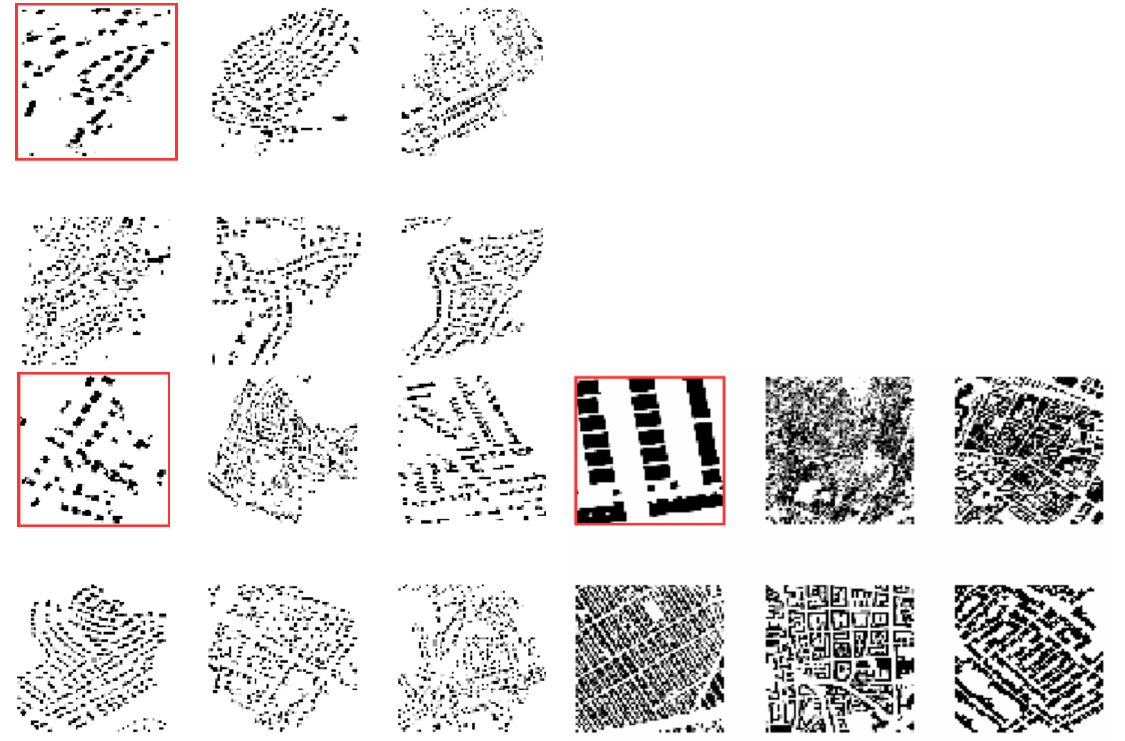
Figure 11. Results of Test 2. The data sample surrounded with a red square is the query image. The remaining 5 images are images that have the shortest Euclidean distance at the manifold from the image encoded by